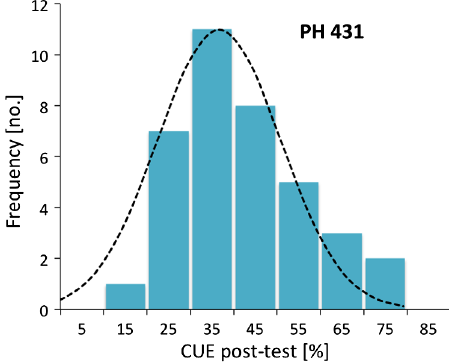
FIG. 4. Histogram of the students ’ scores on the CUE post-test based on N ¼ 37 students in three courses. The dotted line shows the Gaussian best fit to the data.